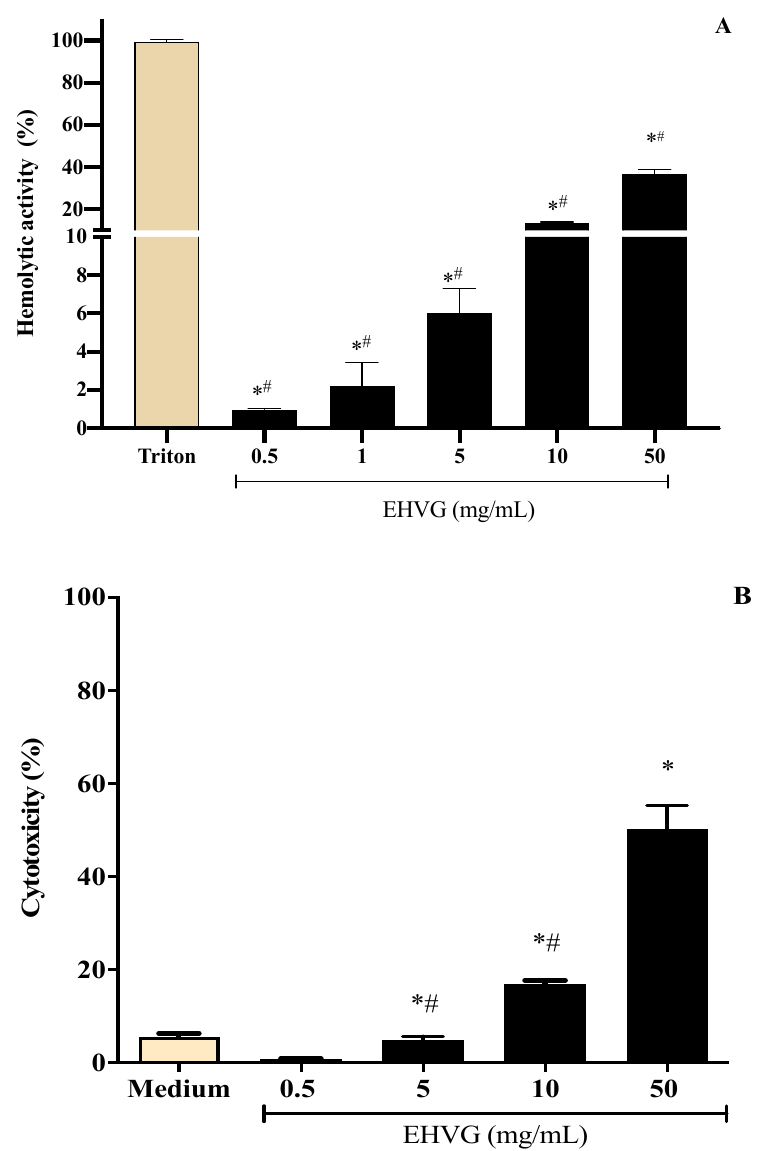
Figure 5. Different concentrations of the hydroalcoholic leaf extract of Vismia guianensis (EHVG) showed low toxicity when evaluated by the hemolysis ( A ) and MTT assay ( B ). Triton was the positive control for hemolysis ( A ) and medium was the negative control in the cytotoxic assay. Data represent the mean ± standard deviation of individual samples tested in quadruplicate. (*) p < 0.05 compared to the control; (#) p < 0.05 compared with other concentrations.